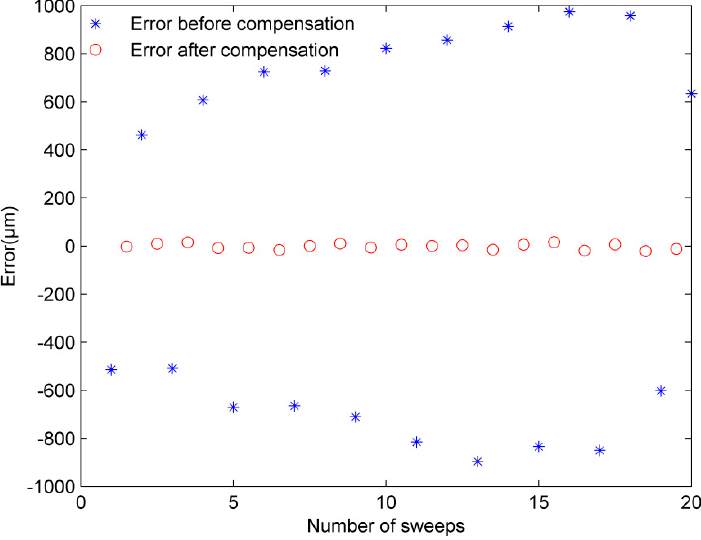
Figure 4. Distance error before and after the vibration compensation at the frequency of 1 Hz and the amplitude of 10 μ m.